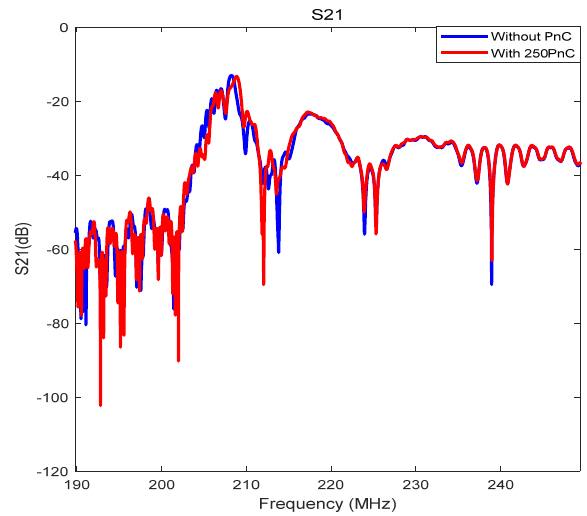
Figure 11. Responses of fabricated Love wave mode delay lines.